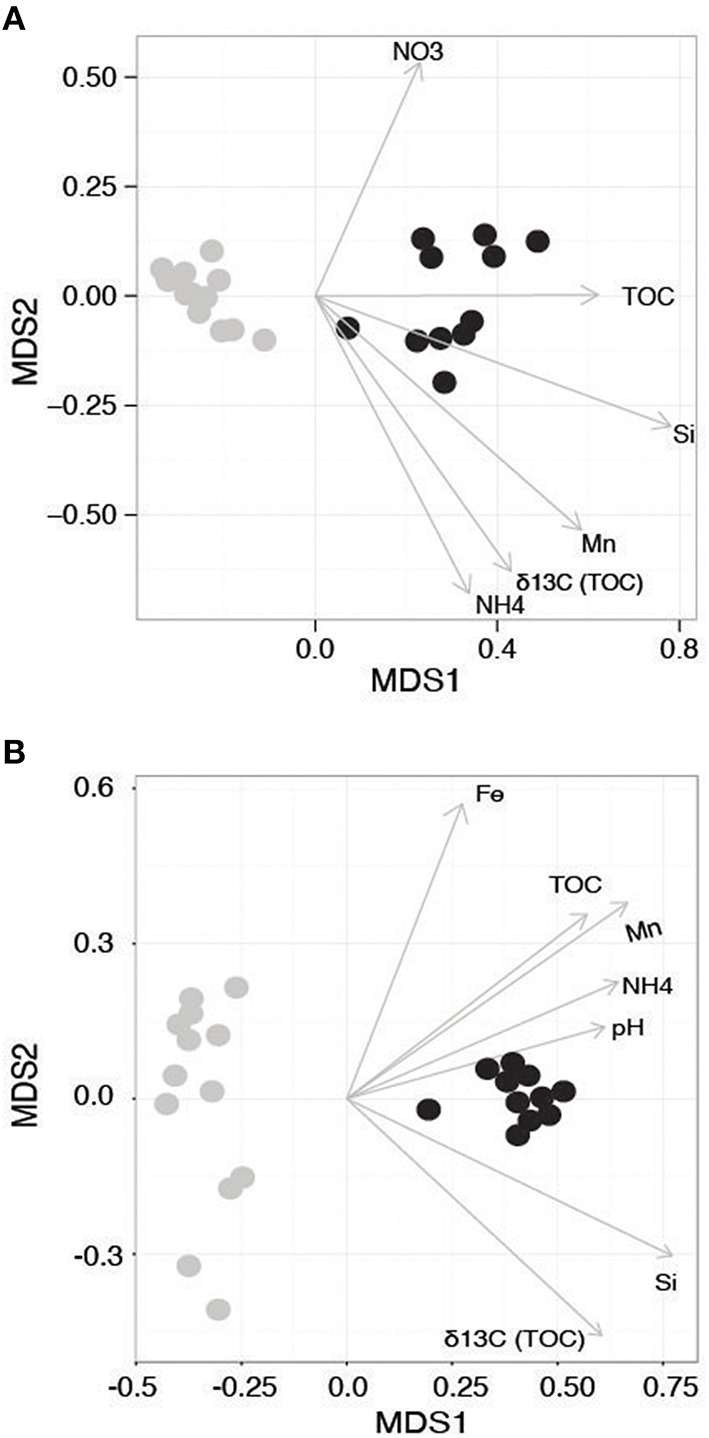
Non-metric Multidimensional Scaling (NMDS) ordination of the beta diversity of the (A) 16S and (B) 18S rRNA-defined communities. Samples from Western Antarctica (WA) are gray and Antarctic Peninsula (AP) samples are black. Arrows denote environmental gradients that statistically correlate with the ordination.